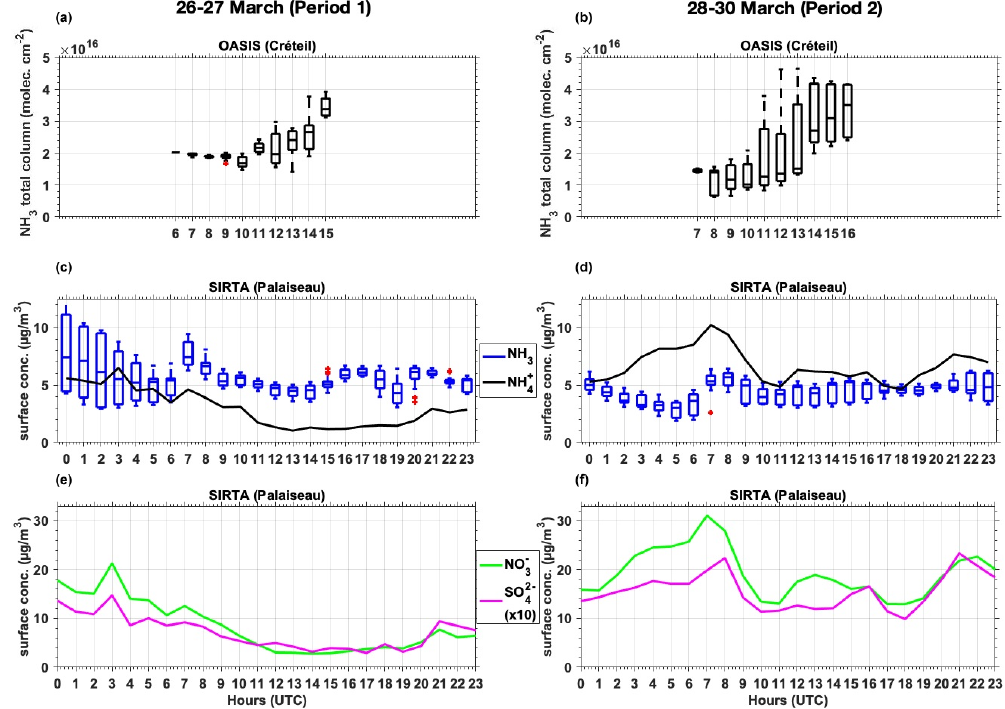
Figure 7. Average diurnal evolution of total column NH 3 (a, b) , surface NH 3 and NH + (e, f) for period 1 on the left side and period 2 on the right side. Hourly boxplots of NH 3 total column retrieved from OASIS (a, b) and SO − 2 4 and hourly boxplots of NH 3 from surface measurements show within the boxplot the median as a line in the plot, 25th and 75th percentile as the lower and upper border of the box, and whiskers that extend to the most extreme data points, whereby outliers are separately marked with a “+”.